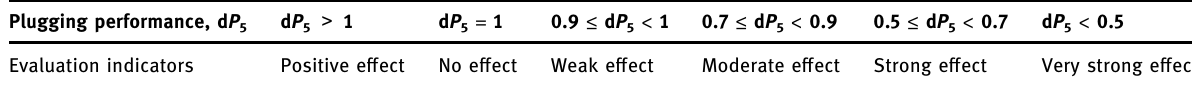
Table 2: Evaluation indicators for the fracture plugging performance of polymer gel Plugging performance, d P 5